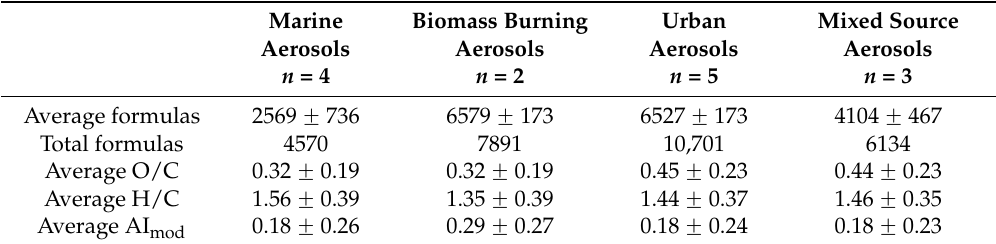
Table 2. Total formulas and average elemental properties for aerosol WSOM PPL and PSOM from each emission source determined using FTICR mass